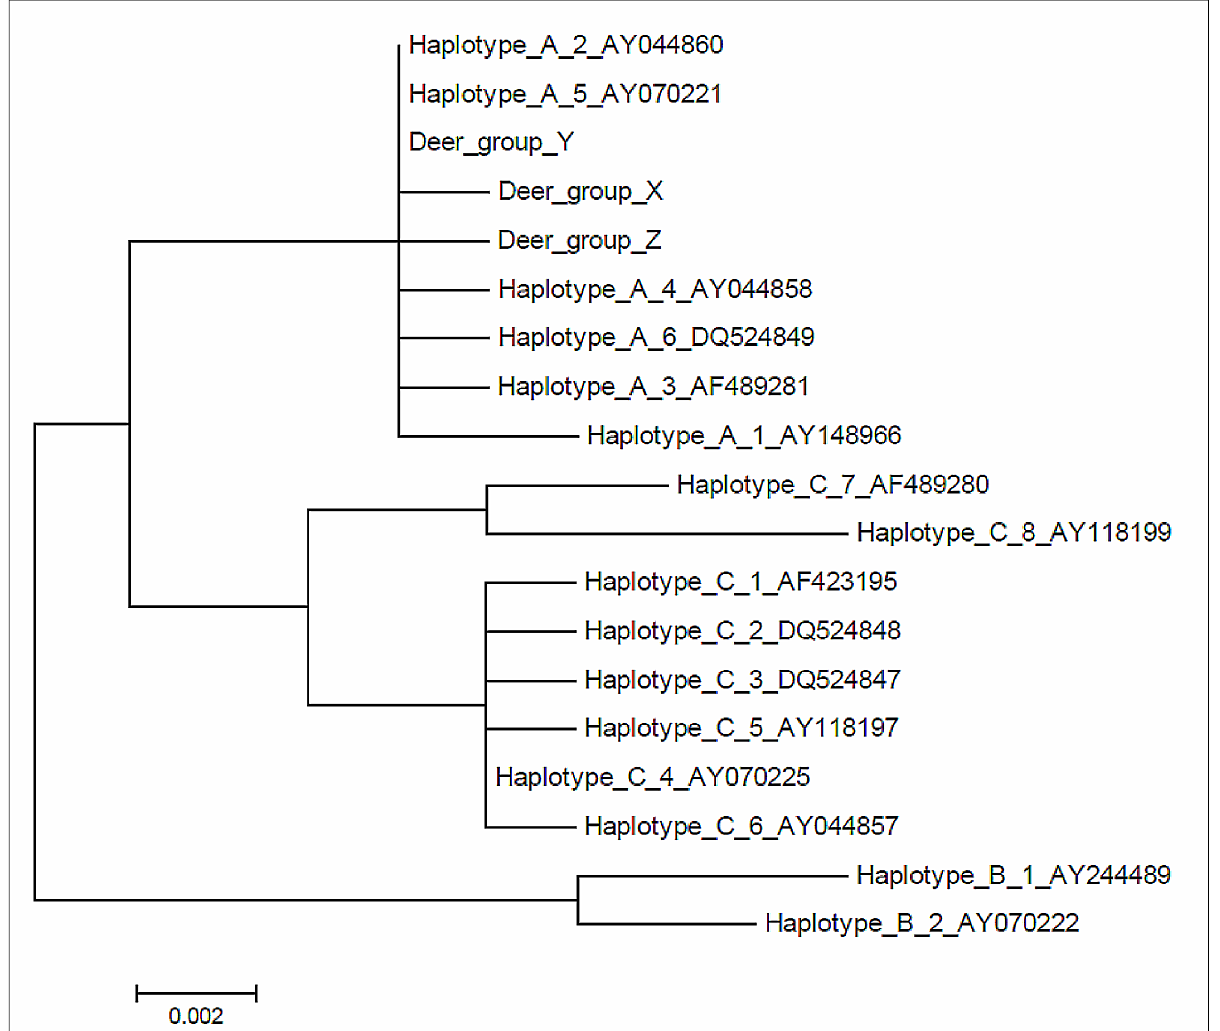
Fig 2. Haplotype genealogy based on maximum likelihood. Mitochondrial haplotype genealogy based on the mitochondrial control region and a maximum likelihood phylogenetic analysis. The haplotypes detected in red deer from the Vosges are indicated in red, all other haplotypes were taken from [3]. Haplotypes belonging to haplotype lineage A are indicated in black, those of haplotype lineages B, C are depicted in grey. Note that some of the haplotypes initially identified by Skog et al. 2009 have collapsed into a single haplotype in our analyses, which is due to the use of a shorter sequences alignment in our analysis to match the length of the newly obtained